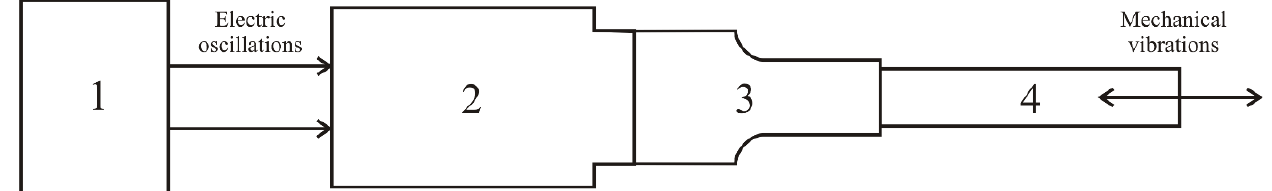
Figure 1. Schematic representation of a typical ultrasonic vibration system: 1—ultrasonic generator; 2—ultrasonic transducer; 3—concentrator; 4—an instrument (sample).